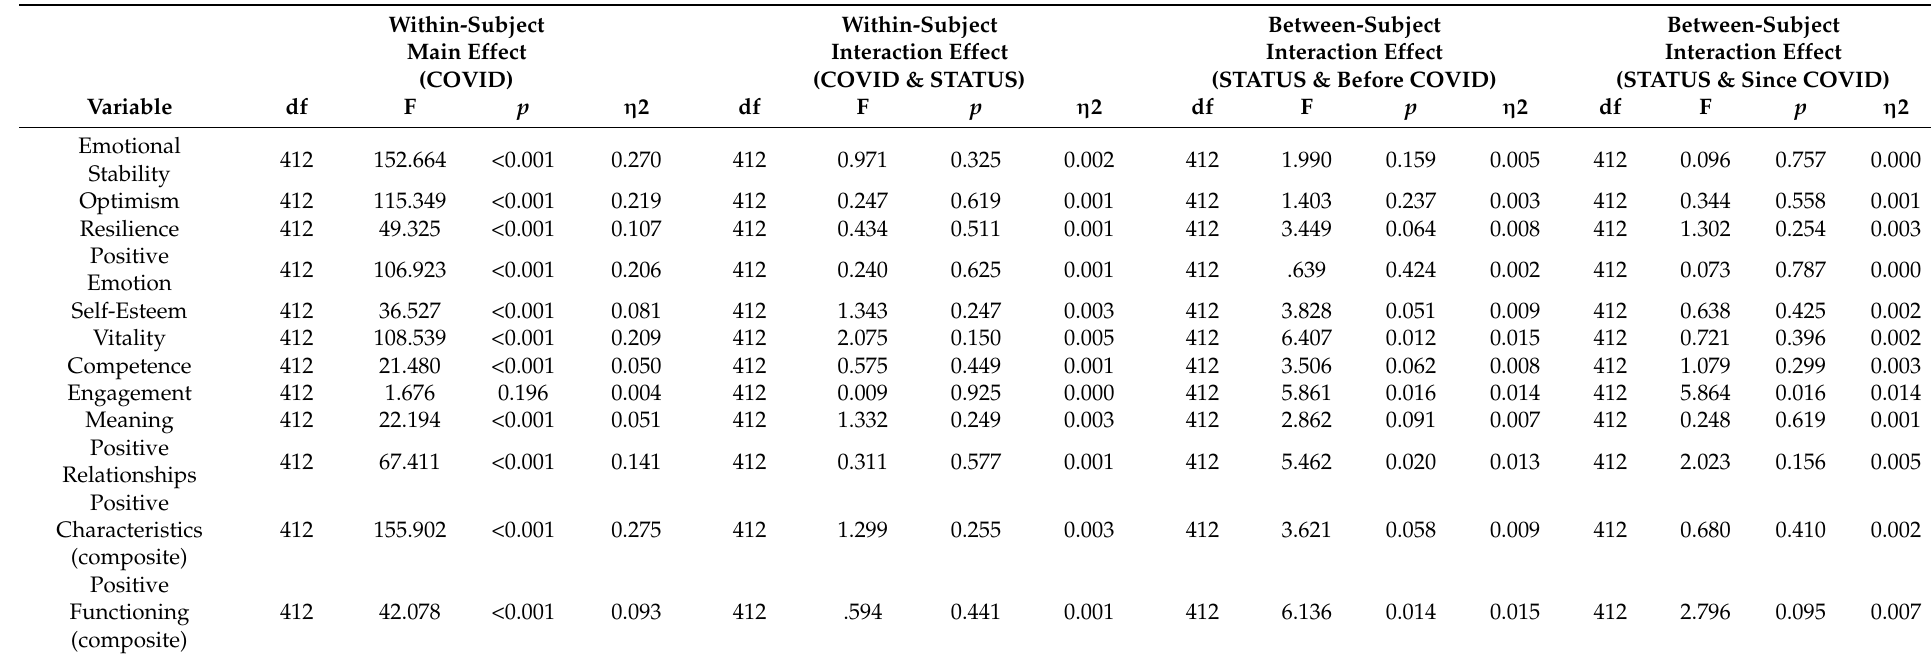
Table 4. ANOVA within- and between-subject main and interaction effects for COVID and student/graduate